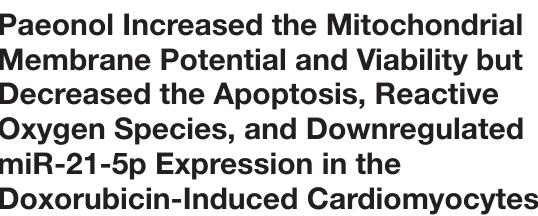
( P < 0.01; Figure 2E ), which indicated that miR-21-5p was involved in the mechanism by which paeonol restored the cardiac function of CHF